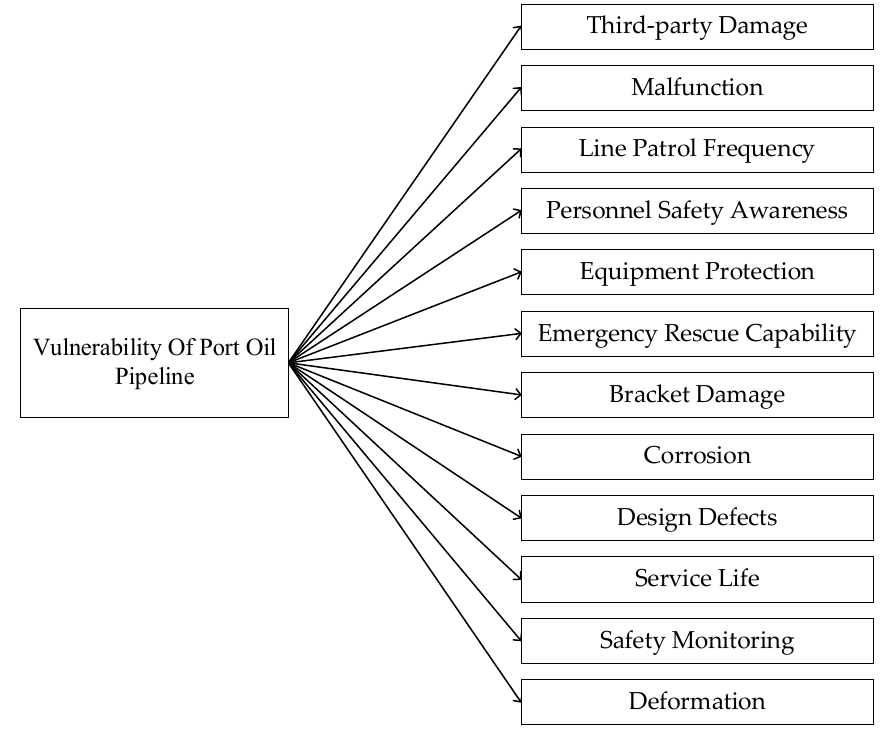
Figure 2. System of evaluation indicators for port Pipeline.